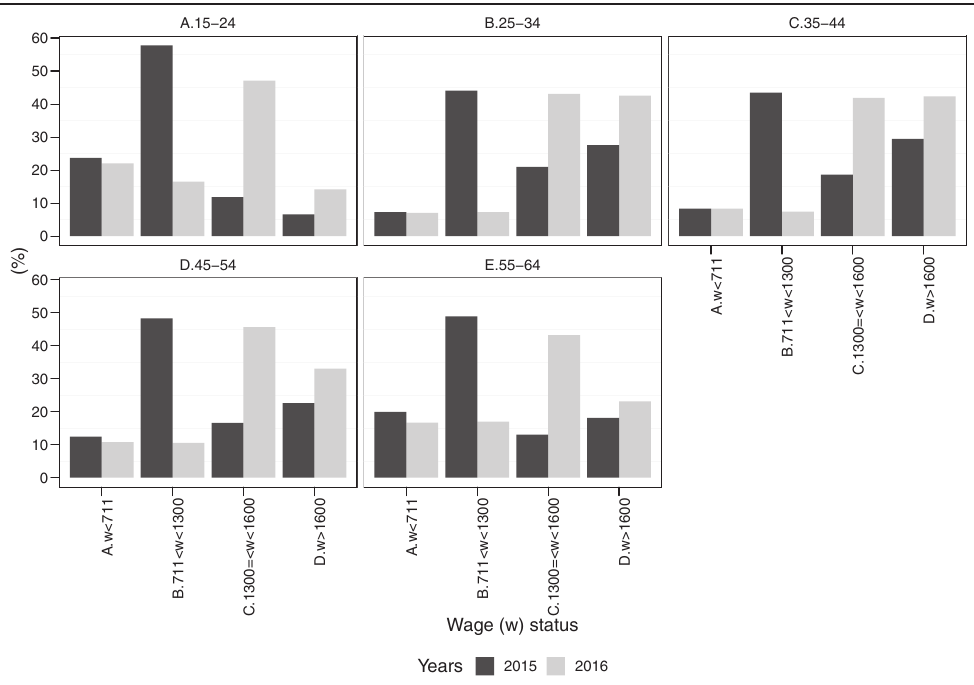
Figure 4 Wage groups potentially affected by the minimum wage increase in 2016, by age